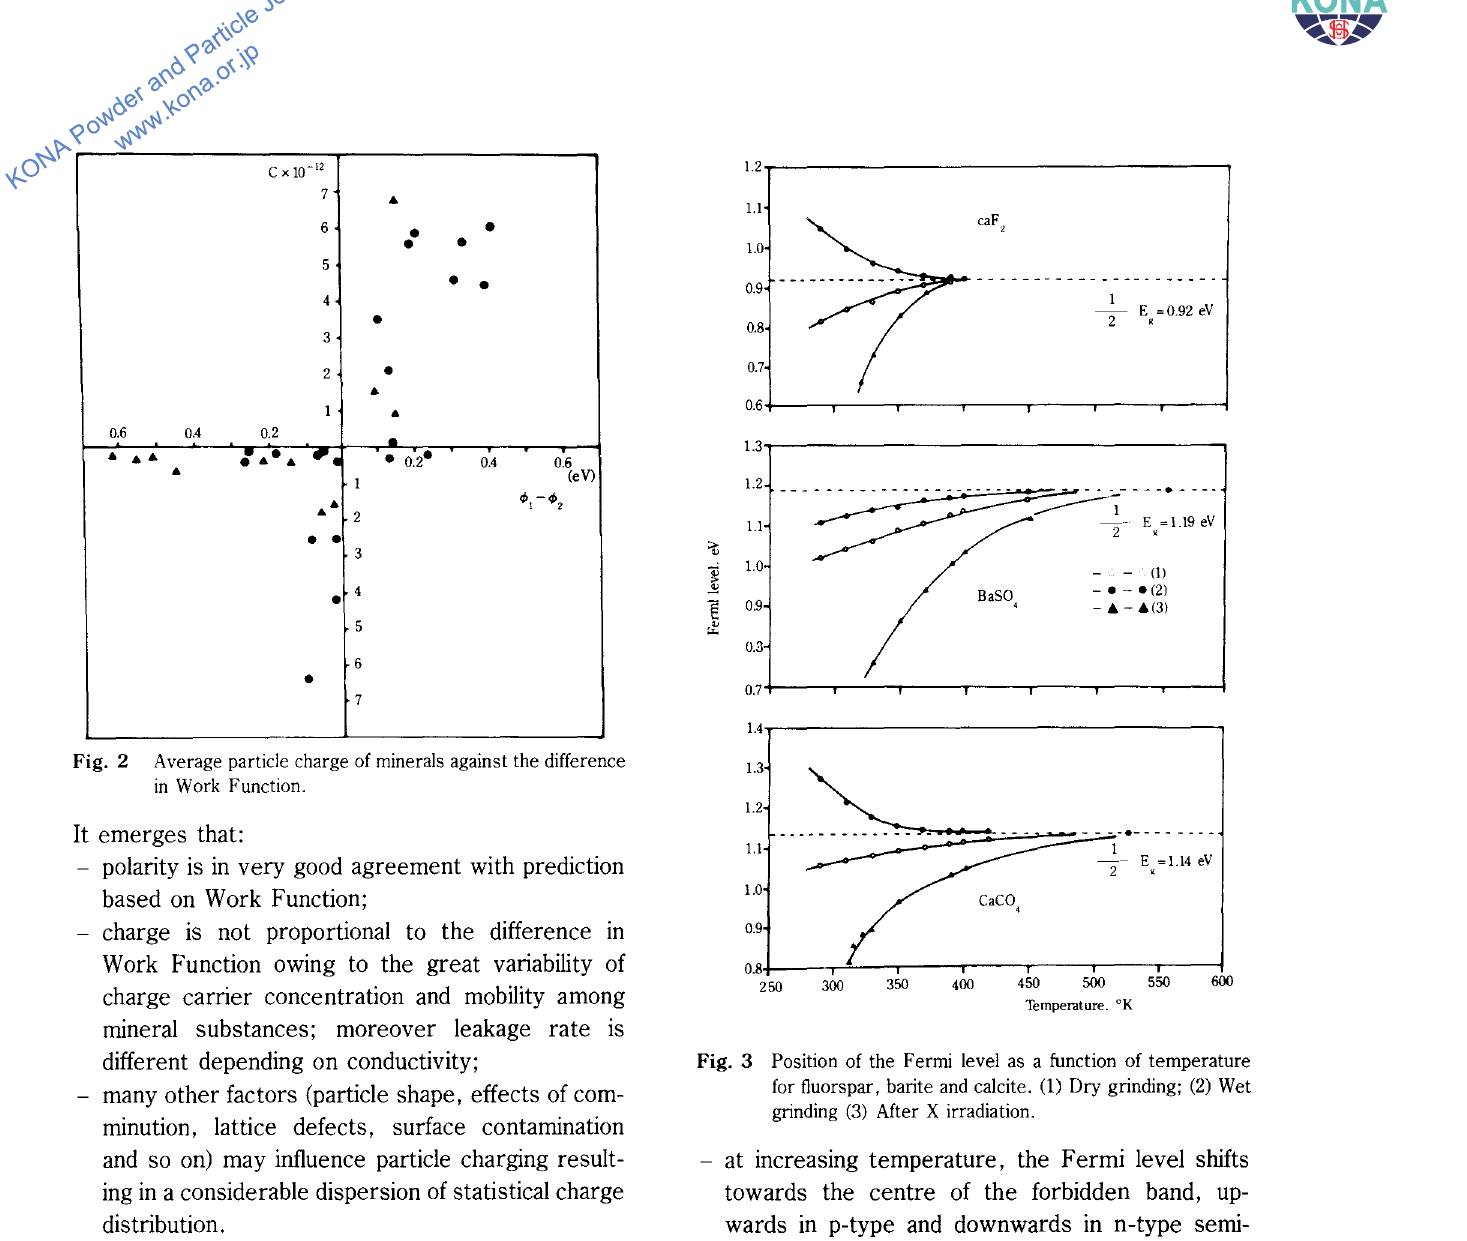
Fig. 3 Position of the Fermi level as a function of temperature for fluorspar, barite and calcite. (1) Dry grinding; (2) Wet grinding (3) After X irradiation. - at increasing temperature, the Fermi level shifts towards the centre of the forbidden band, up wards in p-type and downwards in n-type semi conductors; - fluorspar and calcite behave as n-type semicon ductors if wet-ground, turning into p-type if dry-ground. On the other hand, the behaviour of p-type barite is not affected by comminution, al though its Fermi level is somewhat lower in the case of wet grinding. - X and /' irradiation produce a downwards dis placement of the Fermi level of fluorspar, barite and calcite with respect to that of wet-ground untreated minerals; moreover, fluorite and cal cite turn from n-type into p-type. The behaviour of the same minerals in a static field has been found to be in very good agreement with the indications of the charging study, as con firmed by the results of a test aimed at disclosing the influence of temperature shown in Fig. 4. Each mineral, ground and screened into the